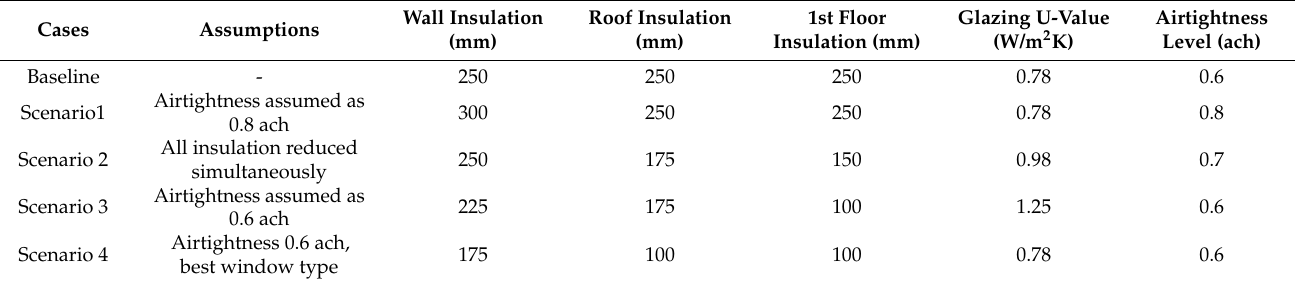
Table 4. Optimal envelope thermal performance solutions under the assumed four